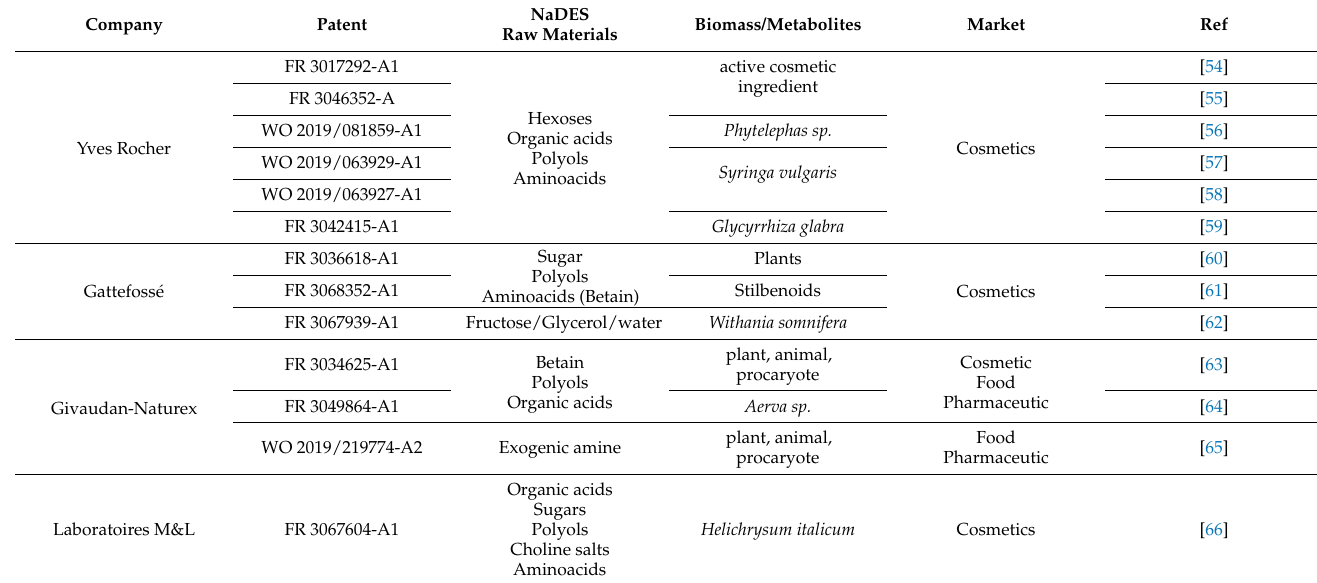
Table 2. Patents with French applicants published since